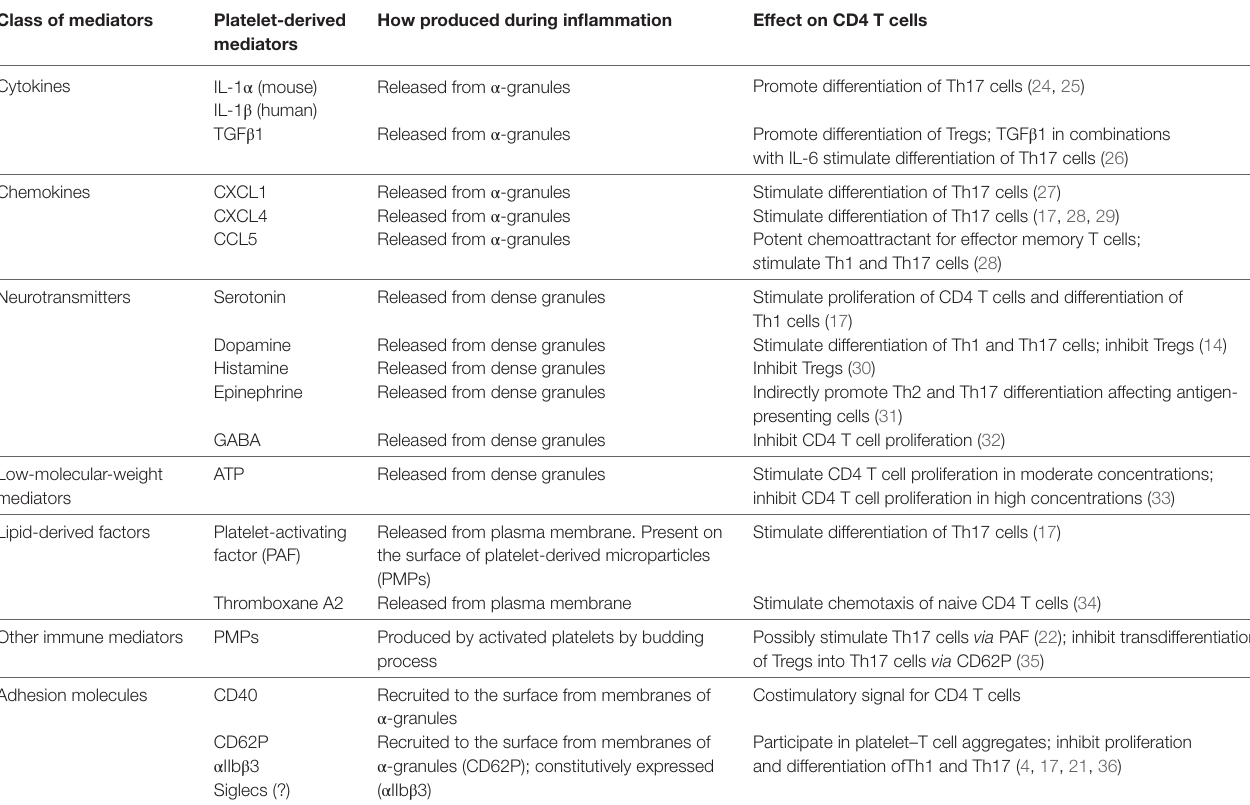
TAbLe 1 | Platelet-derived soluble factors and surface molecules that affect proliferation, differentiation, and migration of Th1, Th17, Th2, and